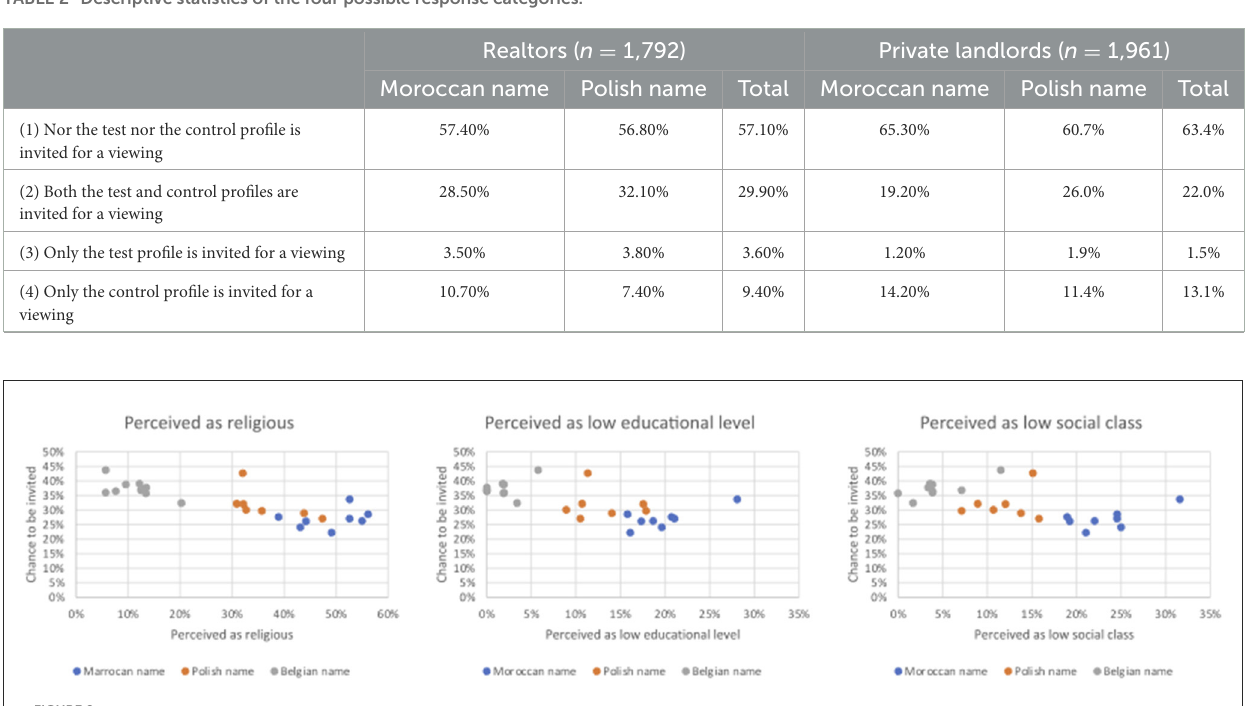
FIGURE2 The invitation rates for each name plotted against religiosity, social class and educational